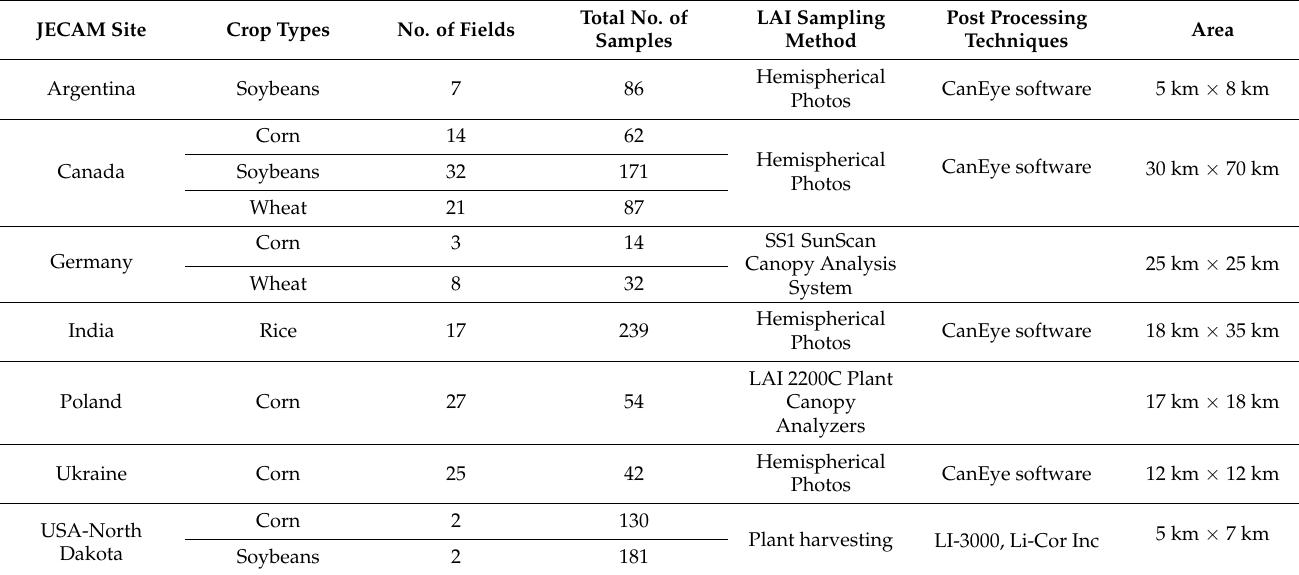
Table 1. Summary of data collected at each JECAM site, including leaf are index (LAI) sampling method and post- processing